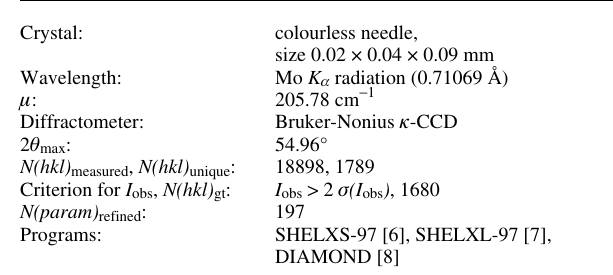
Table 1. Data collection and